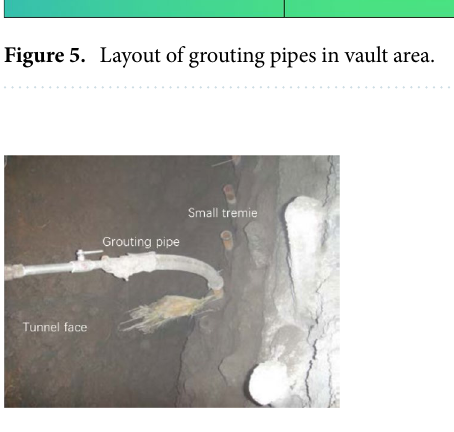
Figure 6. In-situ test of superfine cement